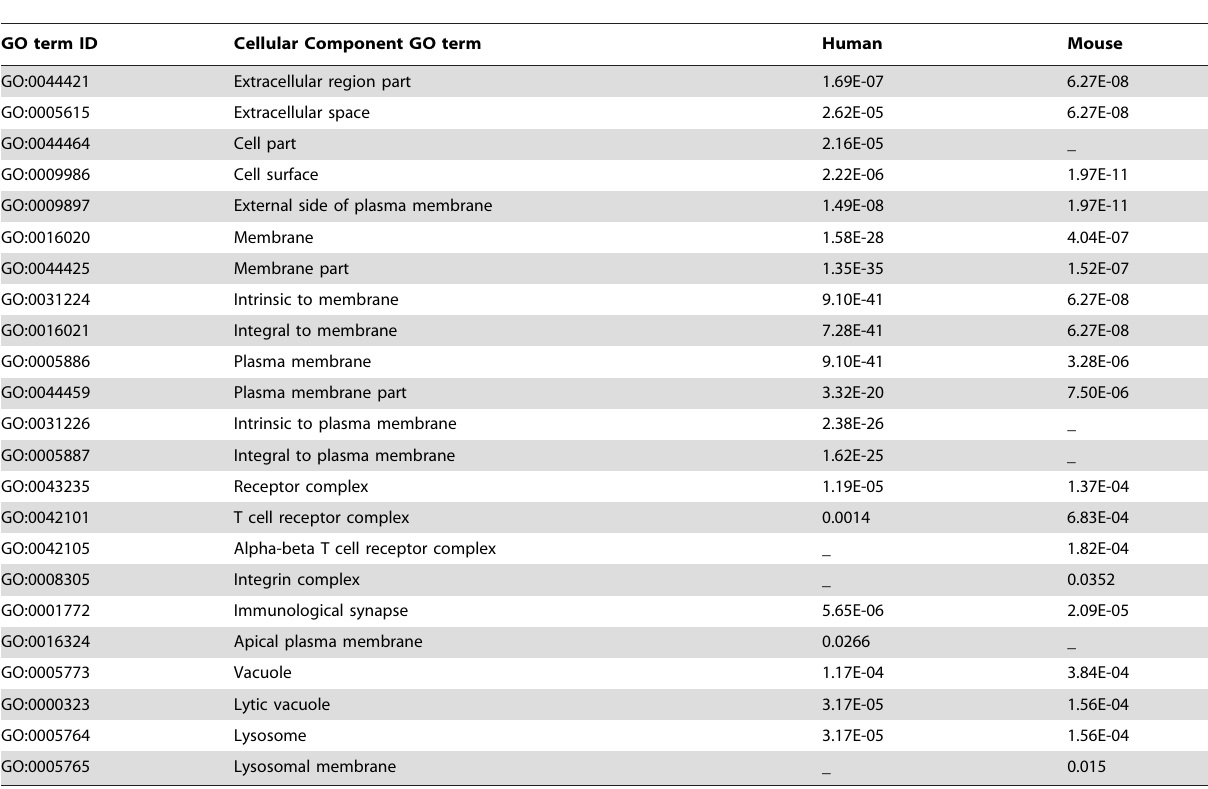
Table 4. Cellular Component GO terms enriched with PSG in human and